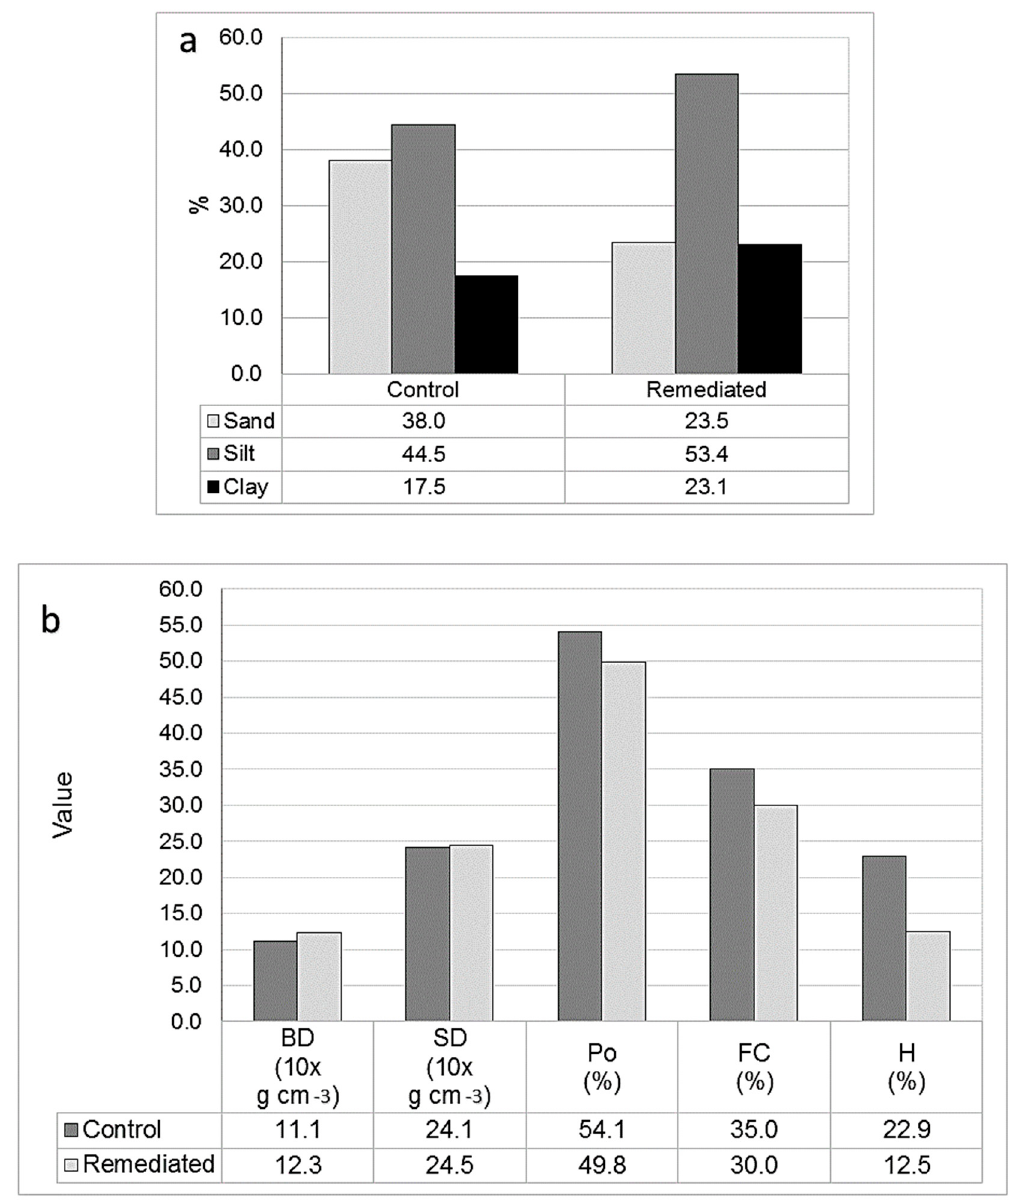
Figure 4. Control and remediated surface soil (0–30 cm, averages n = 5), ( a ) texture and ( b ) bulk density (BD), particle density (SD), porosity (Po), field capacity (FC), and moisture content (H) values.